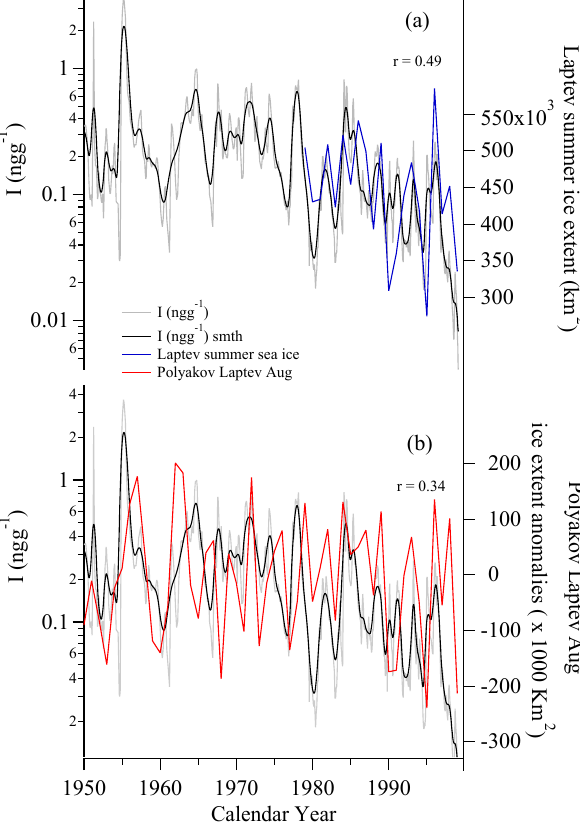
Figure 8. Iodine compared with Laptev Sea summer sea ice area. In both panels, raw (grey line) and 3-year smoothed (black line) (I) data from the Akademii Nauk ice core are shown. The Laptev Sea summer sea ice data are based on satellite observations (blue line, a ) and the reconstruction of Polyakov et al. (2003) (red line, b ). dine sources is that the atmospheric concentrations of IO